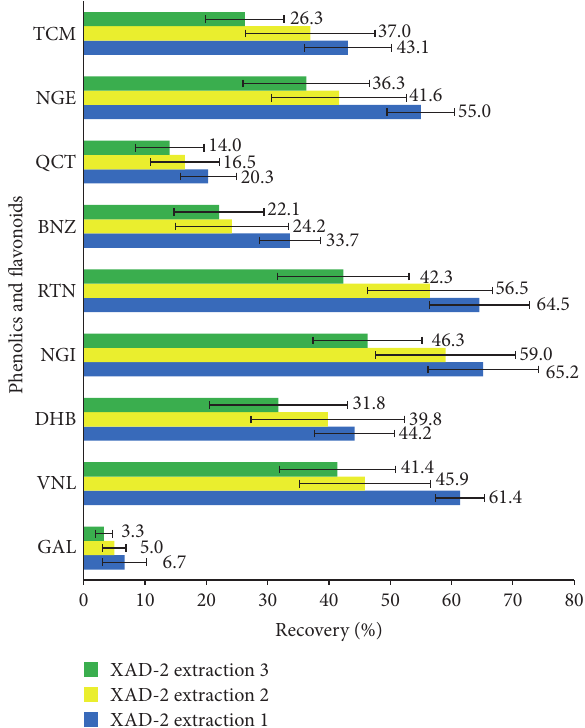
Figure 3: Decrease in polyphenol percentage recovery after reusing Amberlite XAD-2 resin for three consecutive extractions. Gallic acid (GAL), benzoic acid (BNZ), dihydroxybenzoic acid (DHB), naringenin (NGE), naringin (NGI), rutin (RTN), quercetin (QCT), trans-cinnamic acid (TCM), and vanillic acid